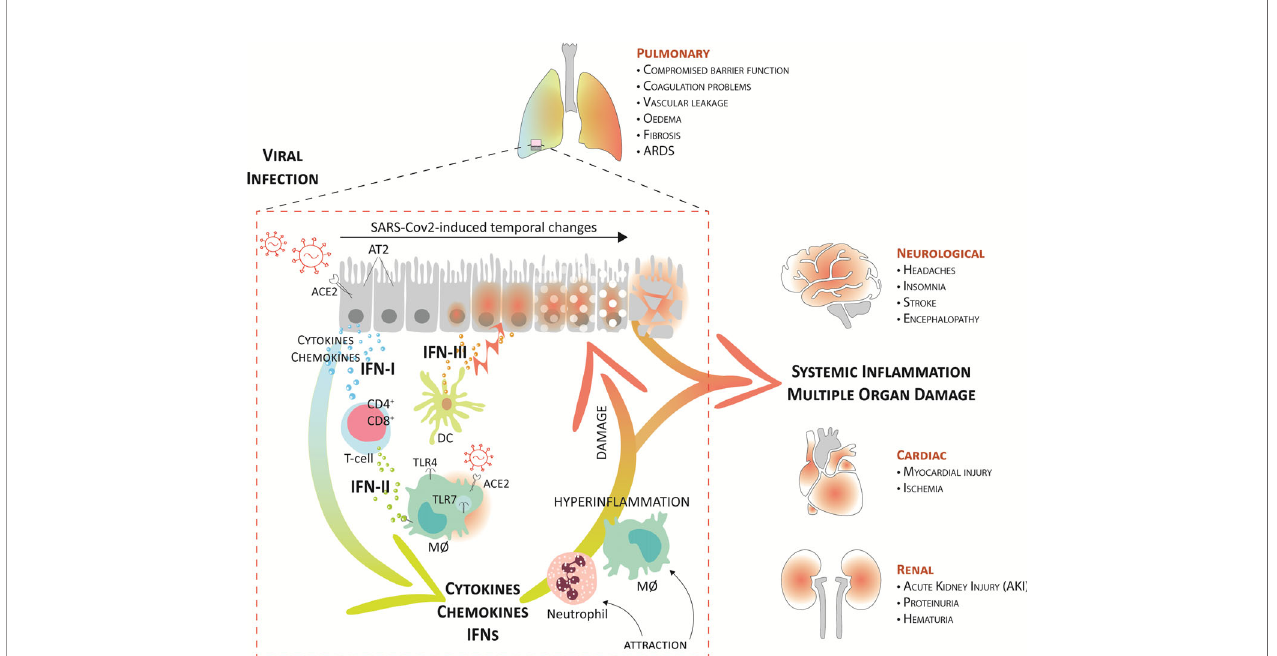
FIGURE 3 | Systemic in fl ammation and multiple organ damage in severe COVID-19. A current model suggests that upon upper airway entry, SARS-CoV-2 impregnates the lower lungs via ACE2, where it infects several target cells, including the alveolar type 2 cells (AT2), alveolar macrophages (MØ), and vascular endothelial cells. Virus cell entry recognition via endosomal and cytosolic pattern recognition receptors (as TLR3 and TLR7) trigger the production of IFNs and proin fl ammatory mediators. Together, the local recruitment of effector T-cells (CD4+ and CD8+) and dendritic cells (DCs), further perpetuates higher proin fl ammatory cytokines, IFNs, and chemokines in the lung fl uid. Consequently, this further augments damage to the lung tissue, mediated by endothelial dysfunction and vasodilation, and leads to the attraction of more in fl ammatory neutrophils and macrophages that create a pathogenic in fl ammatory loop in the lung. On the one hand, this leads to respiratory/organ failure and on the other hand, it also results in a “ systemic cytokine storm ” that causes widespread in fl ammation and damage to other vulnerable organs, like the heart, kidney, and brain. This can rapidly progress to multiple organ exhaustion, which correlates with a poor prognosis in COVID-19